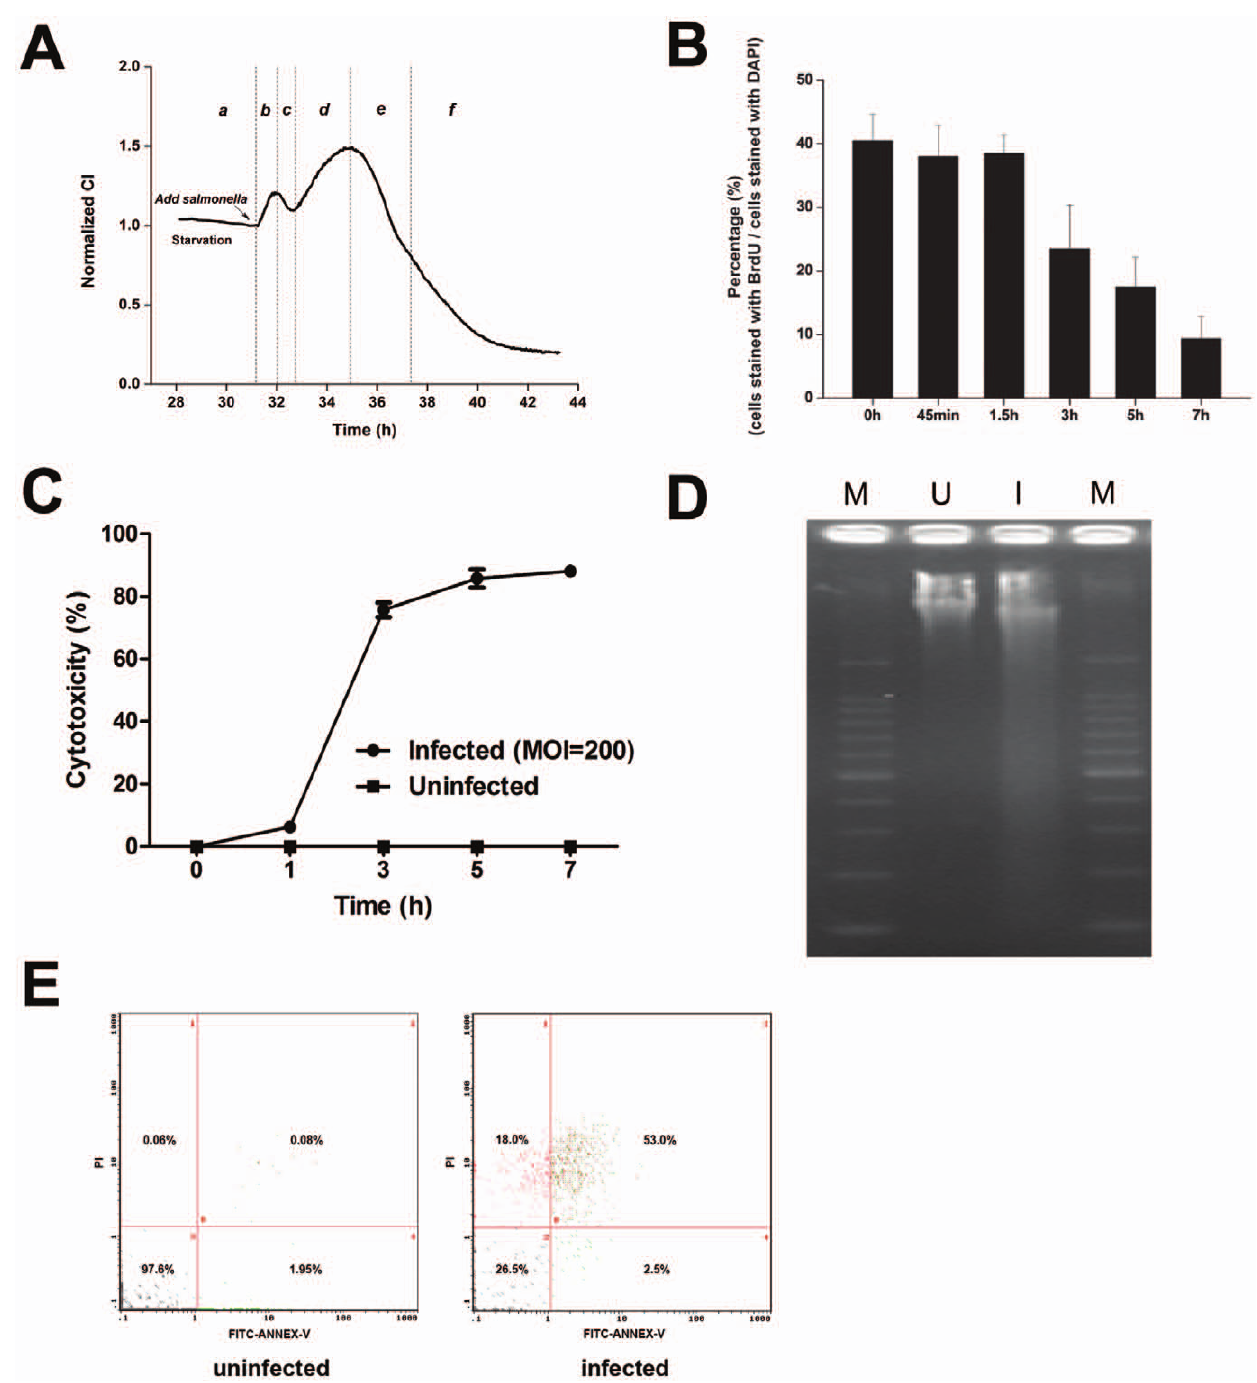
Figure 2. TCRP predicts host cell survival after Salmonella infection. (A) Schematic graph of the TCRP of HT-29 cells in response to S. typhimurium infection (MOI=200). TCRP was divided into phases a through f along the time-axis. Cell samples for endpoint assays at each phase were collected and analyzed. Arrow represents the time points of bacterial addition. (B) Effects of S. typhimurium on cell proliferation. HT-29 cells were infected with S. typhimurium (MOI=200) for 0, 0.75, 1.5, 3, 5 or 7 h and stained with BrdU and DAPI. Data are expressed as mean 6 SD (n=5). (C) Cytotoxic effect of S. typhimurium on HT-29 cells. Cells were infected with S. typhimurium at an MOI of 200 or left uninfected as a control. Cytotoxicity at 0, 1, 3, 5, 7 h was evaluated by LDH release assay (n=4). (D, E) Cell death induced by S. typhimurium infection. HT-29 cells (10 6 cells per well) were seeded into 6-well plates and infected with SL1344 at MOI=200. Cell death induced by Salmonella was analyzed with DNA fragmentation assay (D) and flow cytometer method (E). I, DNA isolated from HT-29 cells infected Salmonella for 7 h; U, DNA isolated from uninfected cells at the same time point. M, DNA molecular marker (100 bp DNA ladder).